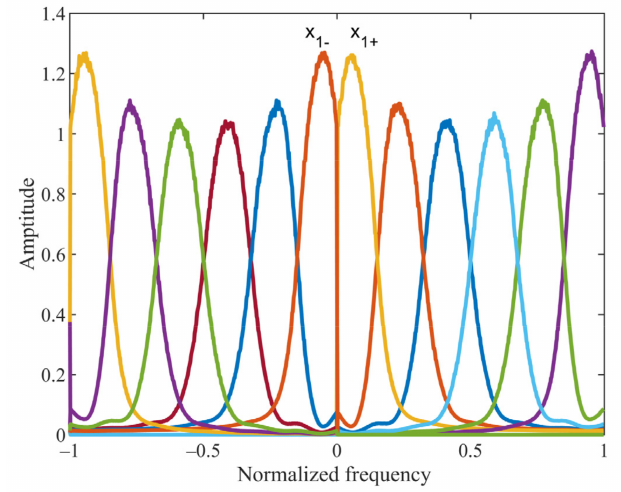
Figure 2. CVMD equivalent filter